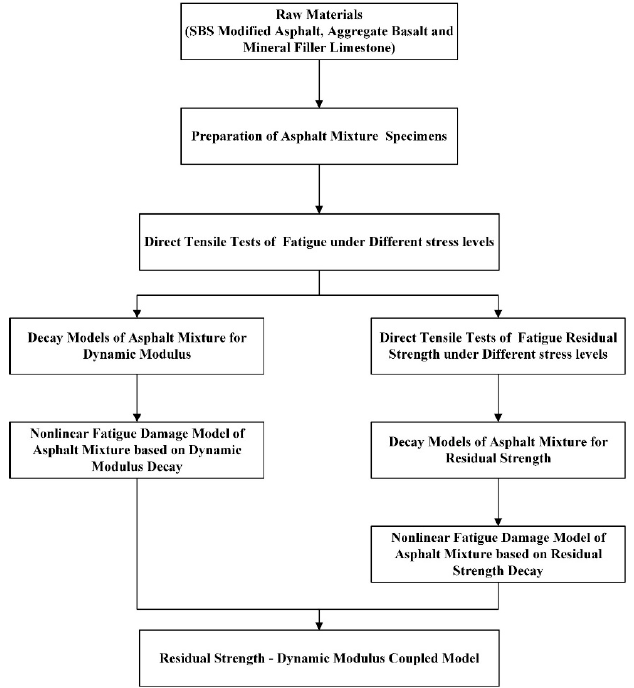
Figure 1. Flowchart of the work.